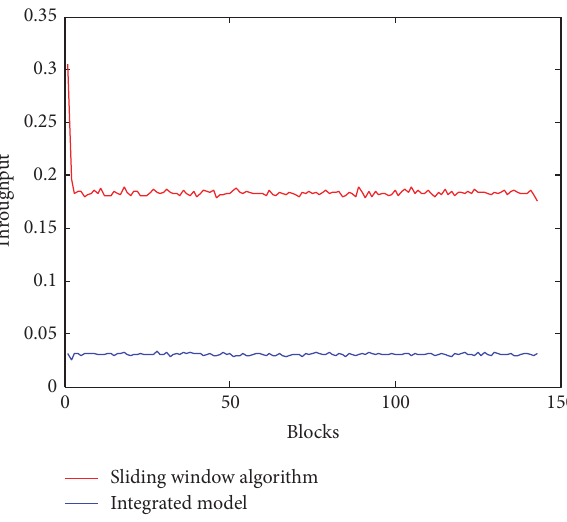
Figure 5: Throughput over 1001 days.